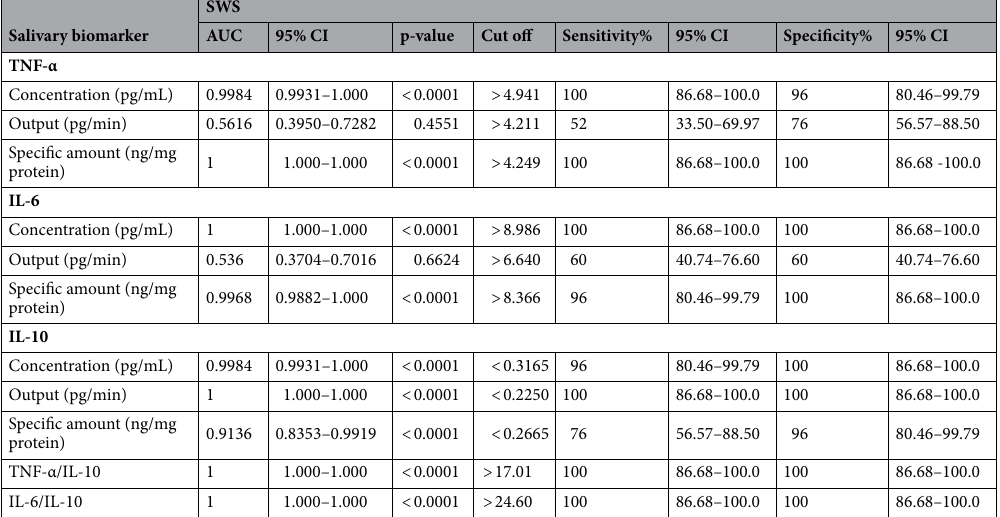
Table 7. Receiver operating characteristics of salivary cytokines in stimulated saliva of stroke patients and healthy controls. TNF-α tumor necrosis factor α, IL-6 interleukin 6, IL-10 interleukin